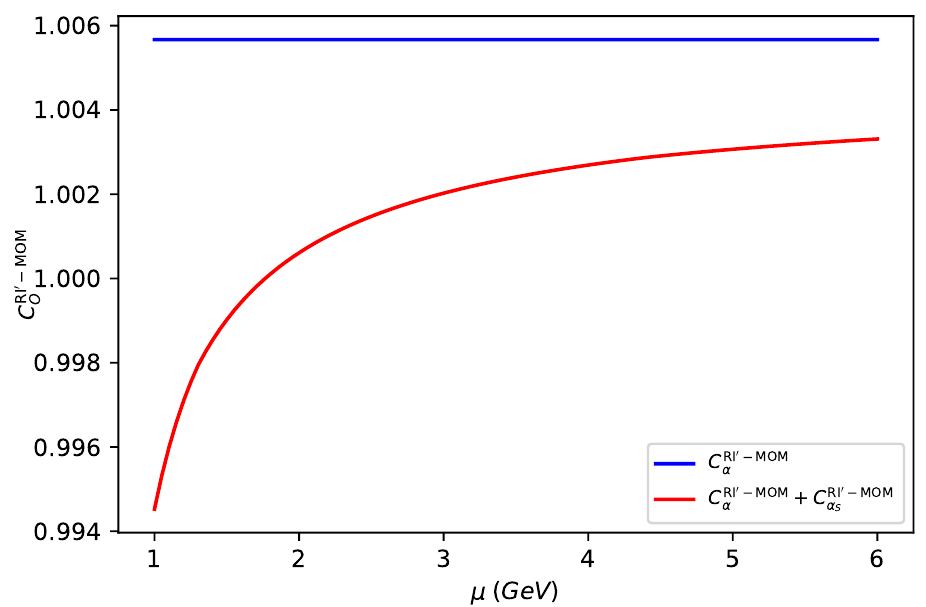
Figure 4. Residual µ -dependence of the low-scale Wilson coefficient C RI 0